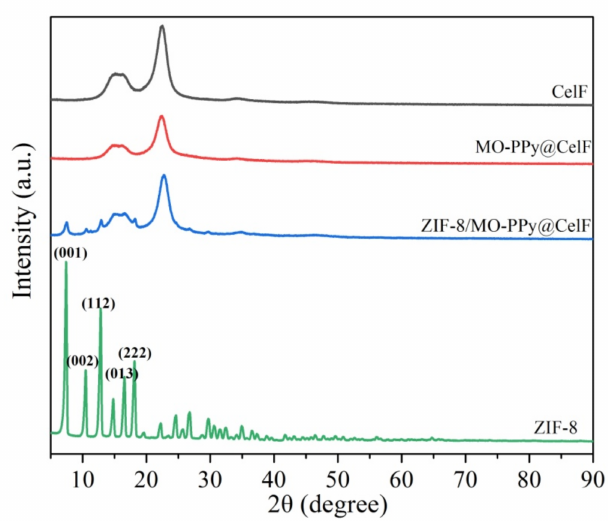
Figure 4. XRD curves of CelF, MO-PPy@CelF, ZIF-8 and ZIF-8/MO-PPy@CelF.